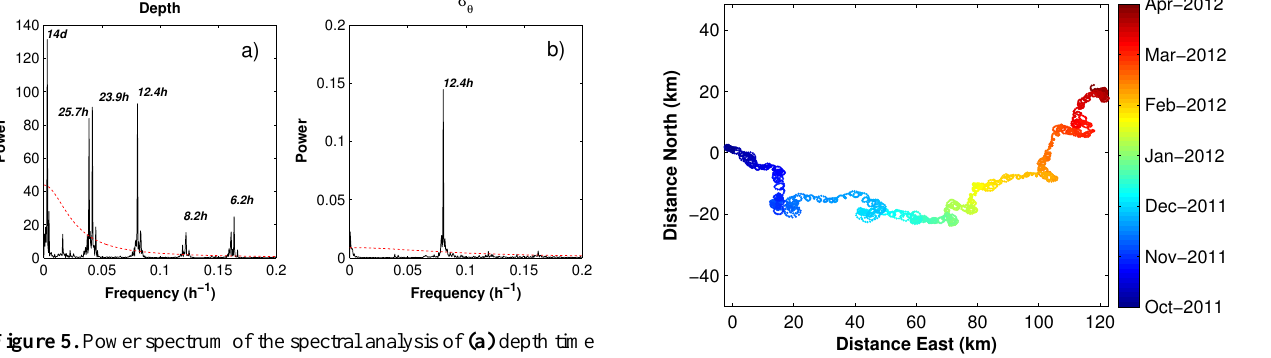
Figure 6. Progressive vector diagram (integration of the current vectors all along the current meter record) calculated from current meter data at 319m. The colour scale refers to